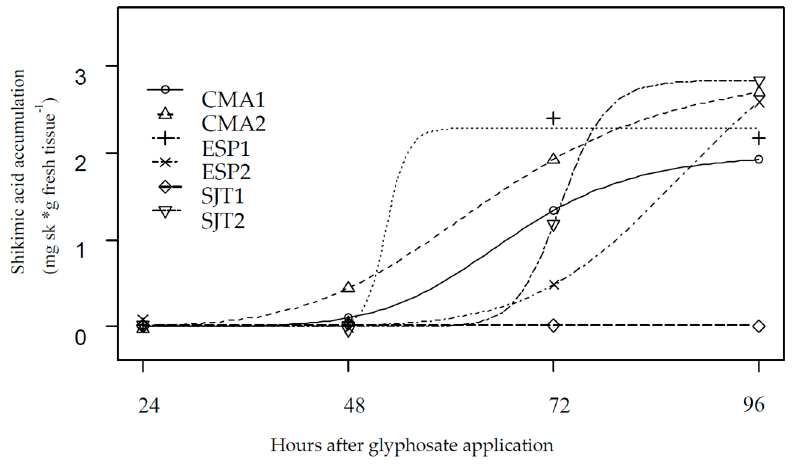
Figure 4. Shikimic acid accumulation over untreated plants from 24 h to 96 h after glyphosate application (mg/g fresh tissue).